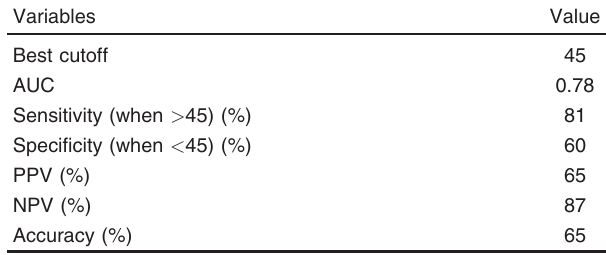
Table 8 Correlation between diffusion lung capacity for carbon monoxide and International Physical Activity